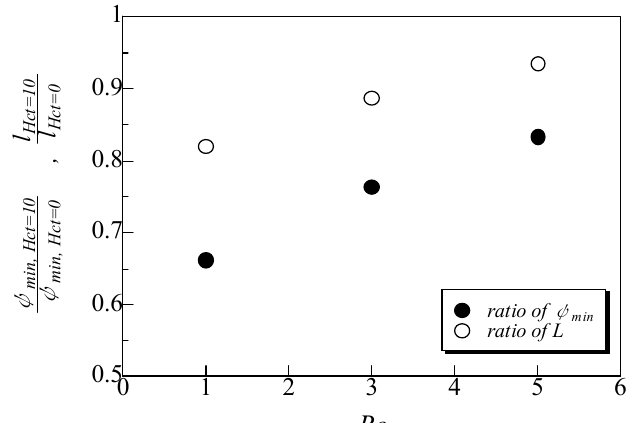
Fig.8 Effect of Re on the ratio of vortex strength and separated length with Hct = 10% to those with Hct =